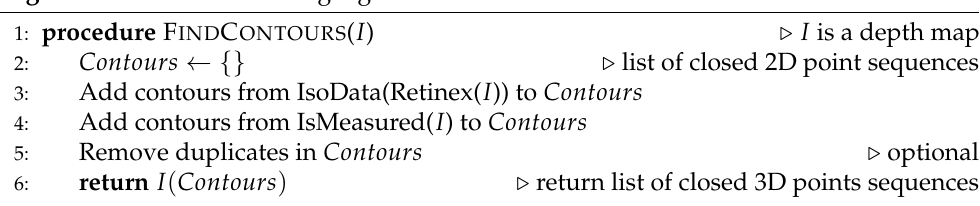
Algorithm 1 Contours finding